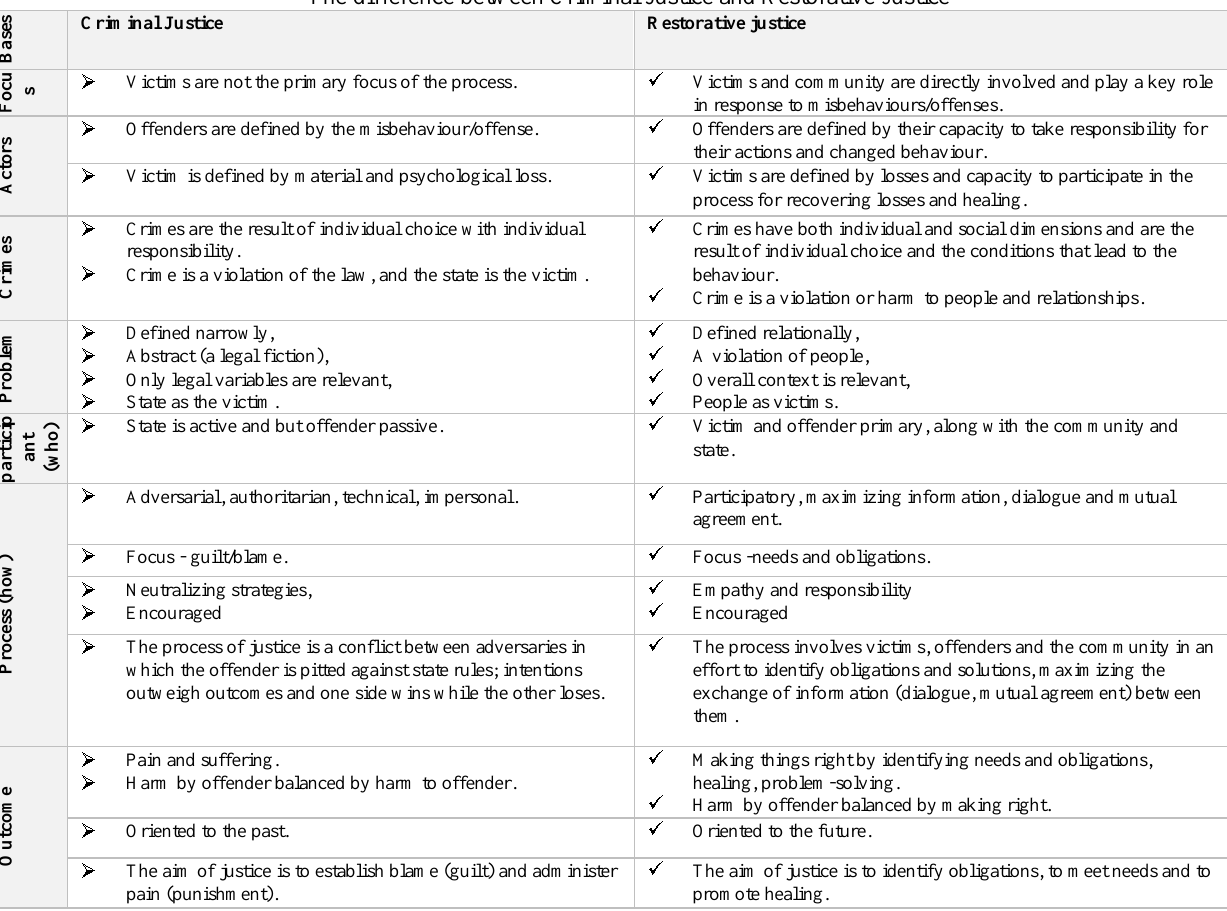
The difference between Criminal Justice and Restorative